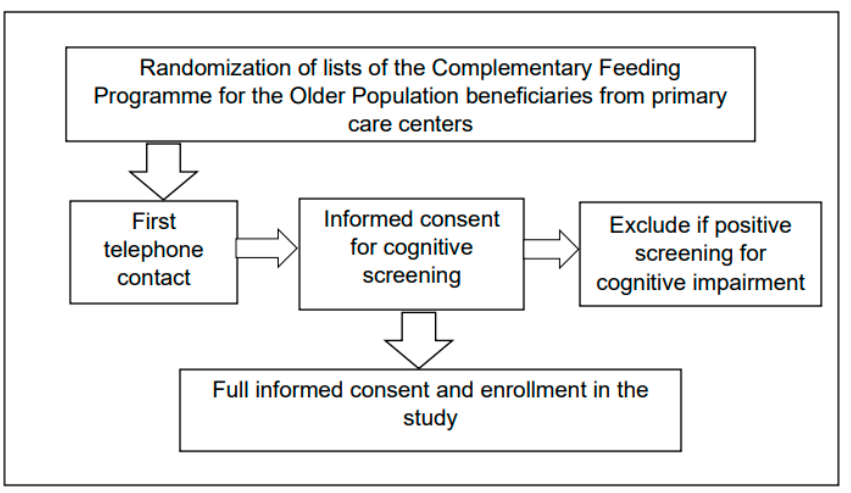
Figure 1. Diagram of the recruitment process.